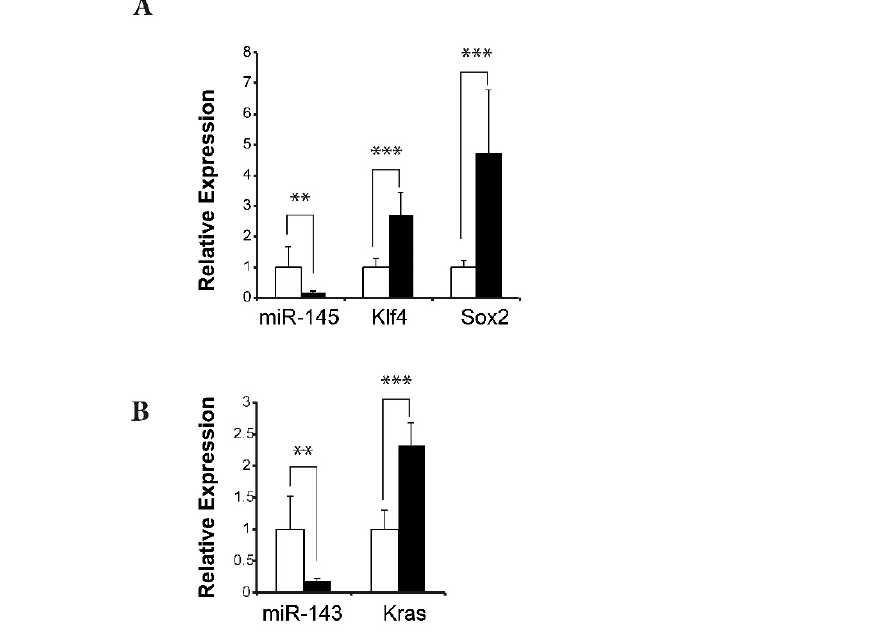
Figure 5. Expression of miR-145 and miR-143 and their downstream, stem cell-related gene targets in normal, transgenic mammary tissues (white) and ATF3-induced tumors (black). ( A ) Relative expression of miR-145 and the pluripotency factors Klf4 and Sox2 . ( B ) Relative expression of miR-143 and its target gene Kras . ** p < 0.05. *** p < 0.005.